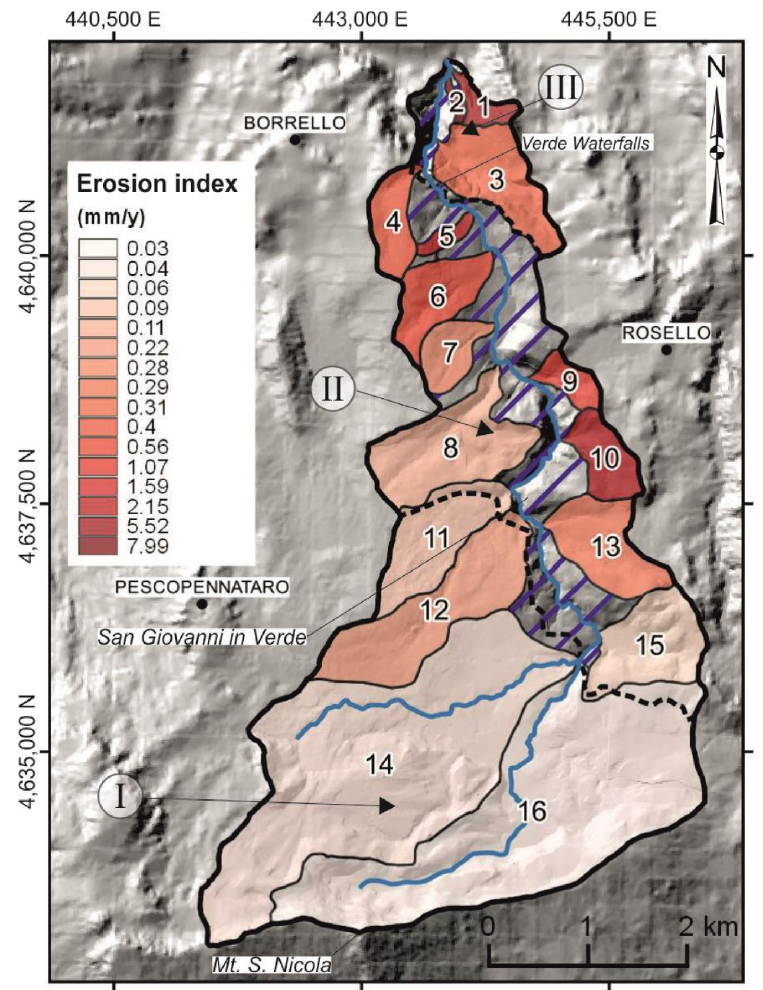
Figure 9. Erosion index map (numbers refer to the drainage sub-basin). The dashed black line indicates the orographic sector boundary (numbers I, II, III); the blue line, the main course of the Verde Stream; the black line, the watershed